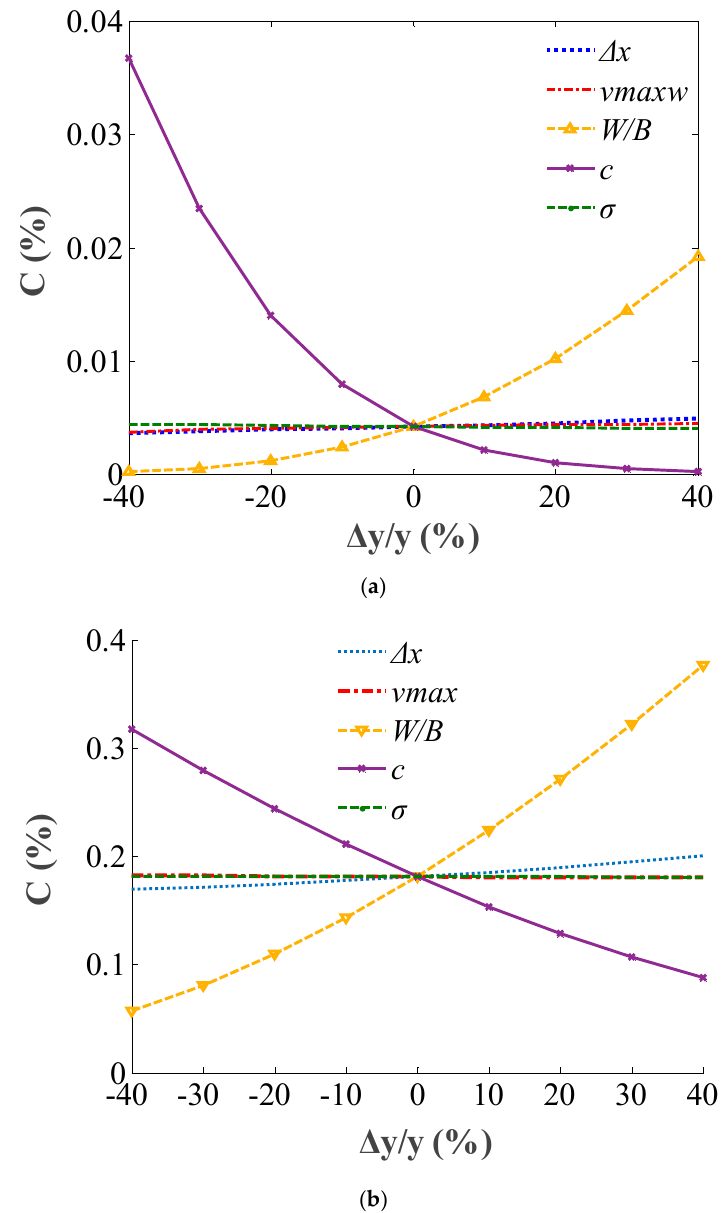
Figure 8. Sensitivity of the concentration of the chloride ion to parameters in the ( a ) inside and ( b ) outside of the lining.